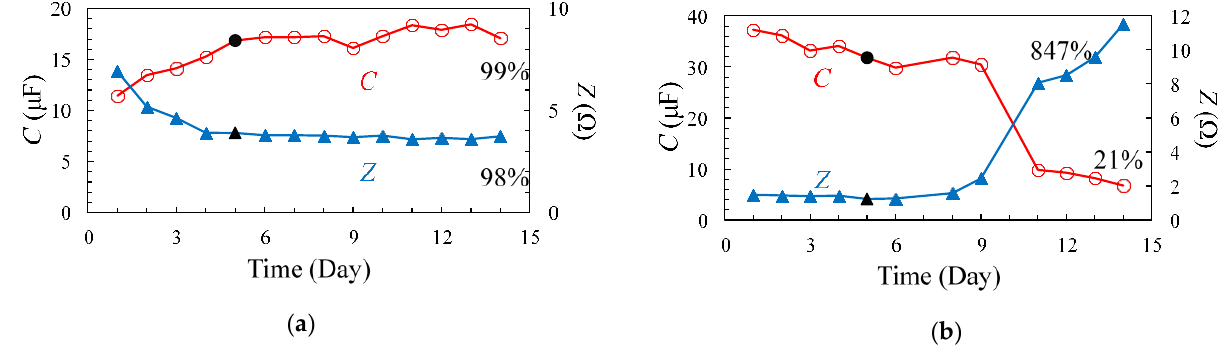
Figure 3. Results of ( a ) C and ( b ) Z measurements in the 80 ◦ C degradation tests.